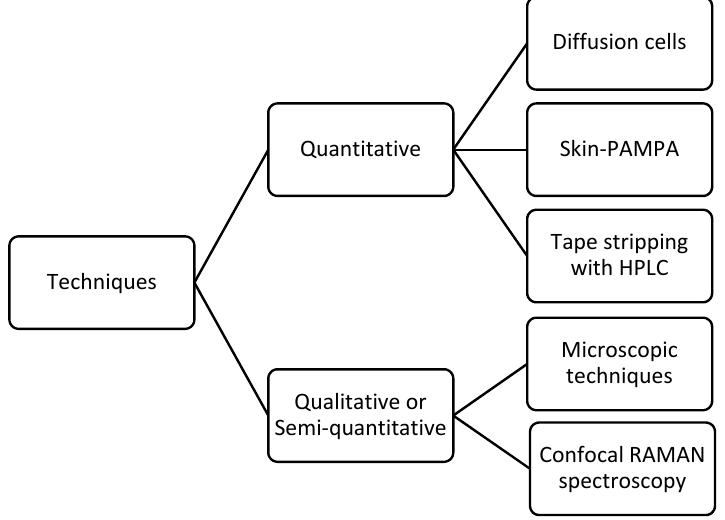
Figure 5. The main quantitative and qualitative methods for following up skin penetration .